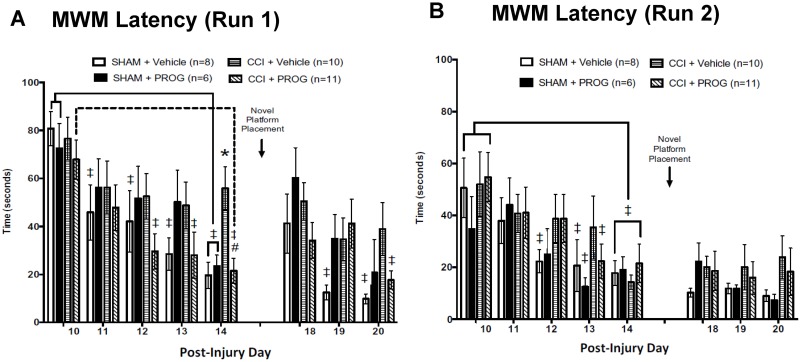
Effects of progesterone (PROG) on learning and memory task as assessed by latency to locate the Morris water maze (MWM) platform.During Run 1 (a) on the acquisition phase there was a significant effect of controlled cortical impact injury. Eight mg/kg PROG proved beneficial by decreasing the mean latency to find a hidden platform in the MWM compared to the CCI+vehicle-treated group. There was no clear effect of PROG treatment on Run 2 (b) or during the reversal phase (p > 0.05). The Sham+PROG group was given 16 mg/kg doses of PROG. * = different from Sham+Vehicle; # = different from CCI+Vehicle (p’s < 0.05). ‡ = different from baseline within each group; n = 6–11.